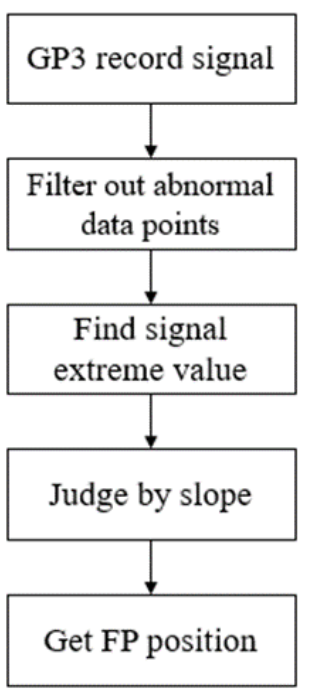
Figure 2. Flowchart of proposed FP position detection. Algorithm 1 Proposed FP position detection